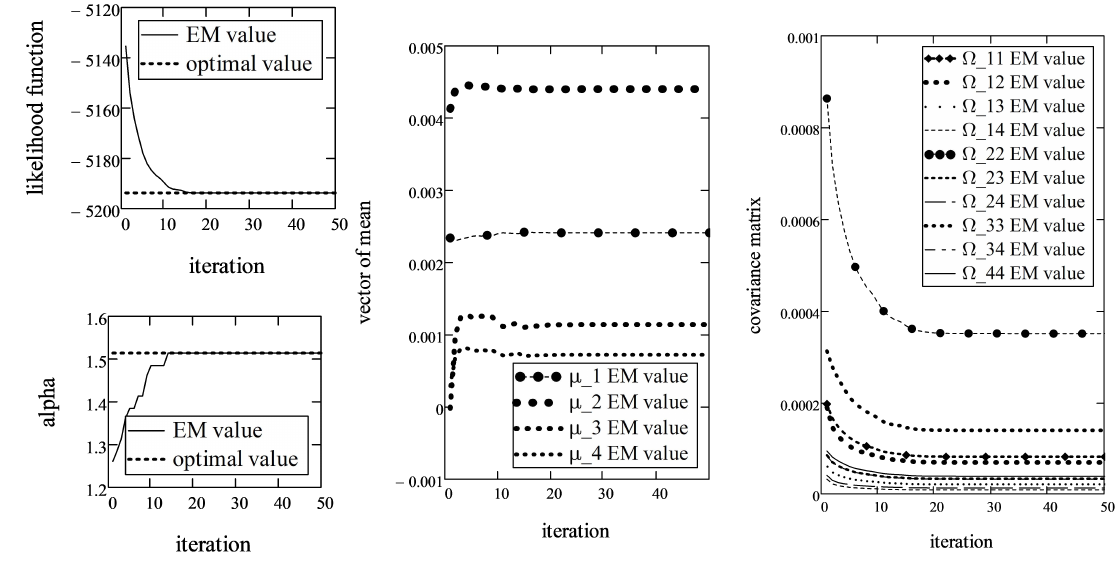
Figure 3. Dependence of the LLF, α , µ and Ω parameters on the number of iterations for d = 4 and K =